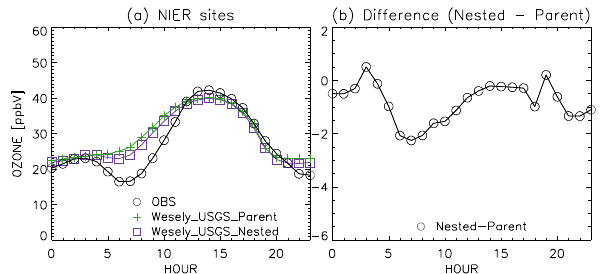
Figure 9. Hourly mean O 3 concentrations averaged over the NIER sites (left) for May 2004. The pluses and squares indicate results from the default (45 × 45km) and nested models (15 × 15km), re- spectively. The observations are denoted with the open circles. The differences between the two models are shown in the right